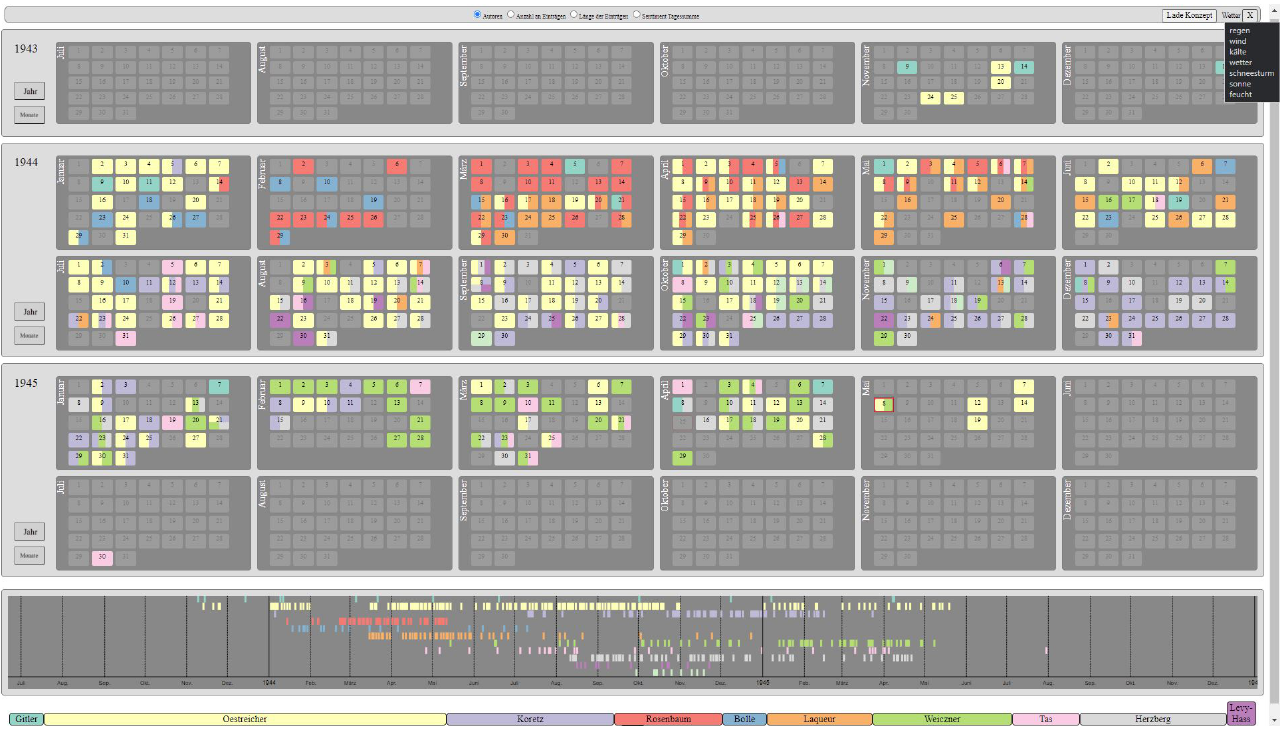
Figure 9. Loading the concept back into the visualization tool, with the result that only texts containing at least one of the concept words are used (at the day